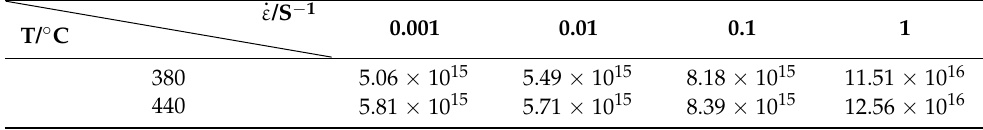
Figure 10. Misorientation Angle (°): ( a ) 380 °C/0.001 s –1 , ( b ) 440 °C/0.001 s –1 . Table 3. Calculated values of ρ GND under various deformation conditions (/m 2